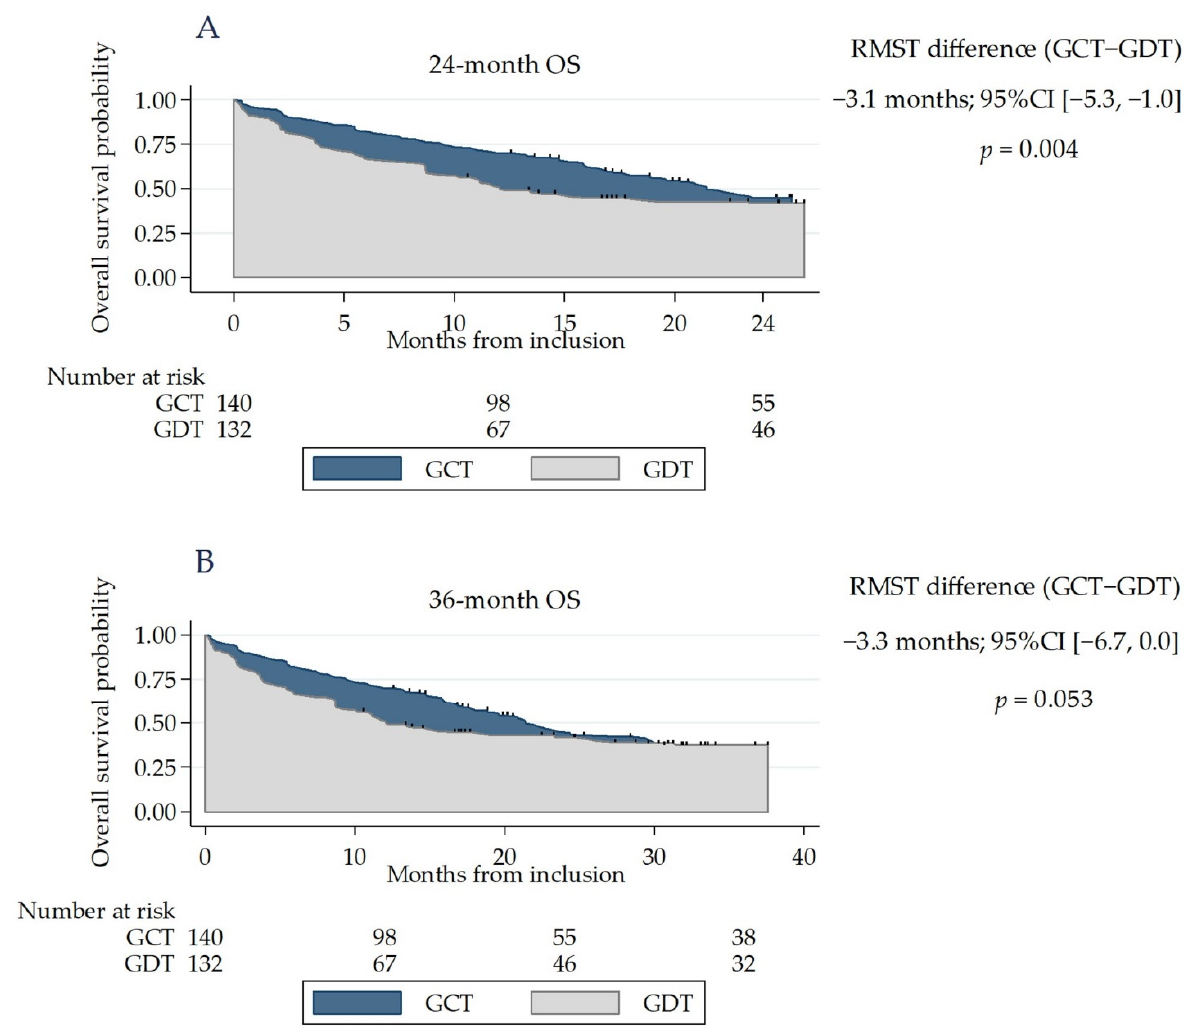
Figure 2. Kaplan–Meier curves for overall survival in the GDT and GCT groups. The area in blue represents the difference in the restricted mean survival time (RMST). ( A ) The weighted population, using SIPTW of propensity scores for 24-month OS. ( B ) The weighted population, using SIPTW of propensity scores for 36-month OS. GCT: guideline-concordant treatment, GDT: guideline–discordant treatment.